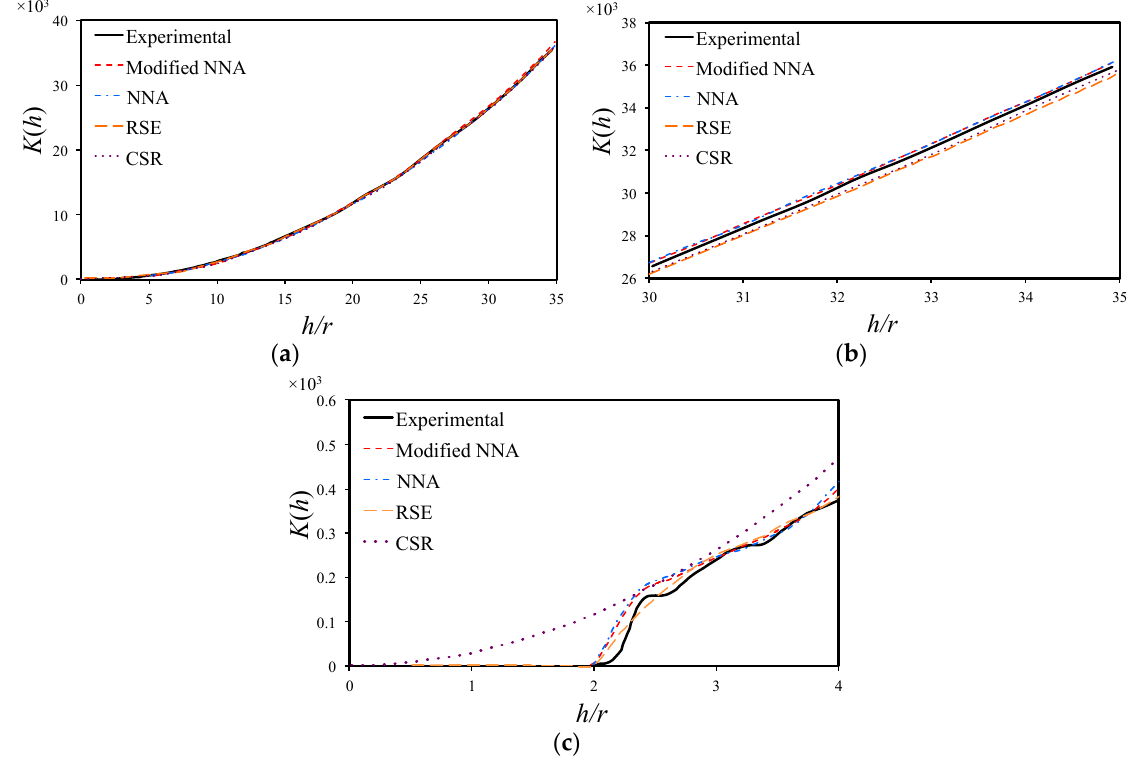
Figure 5. Comparison of experimental measured and computational modeled Ripley’s K function ( a ) 0 ≤ h/r ≤ 35; ( b ) 30 ≤ h/r ≤ 35; and ( c ) 0 ≤ h/r ≤ 4.